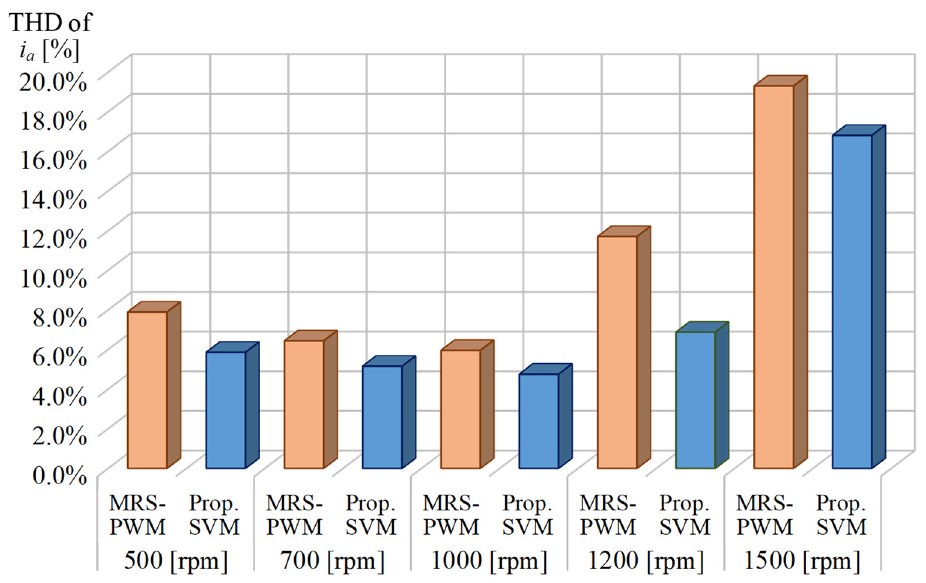
Figure 24. Experimental results at load torque variations: ( a ) Increase of load torque; ( b ) Decrease of load torque.